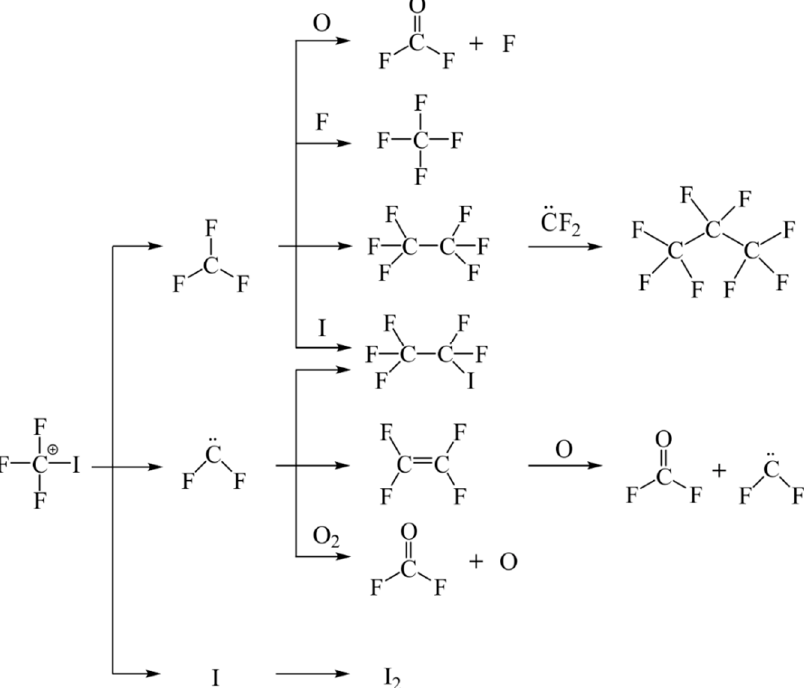
Figure 3. Decomposition mechanism of CH 3 I with O 2 during discharge.